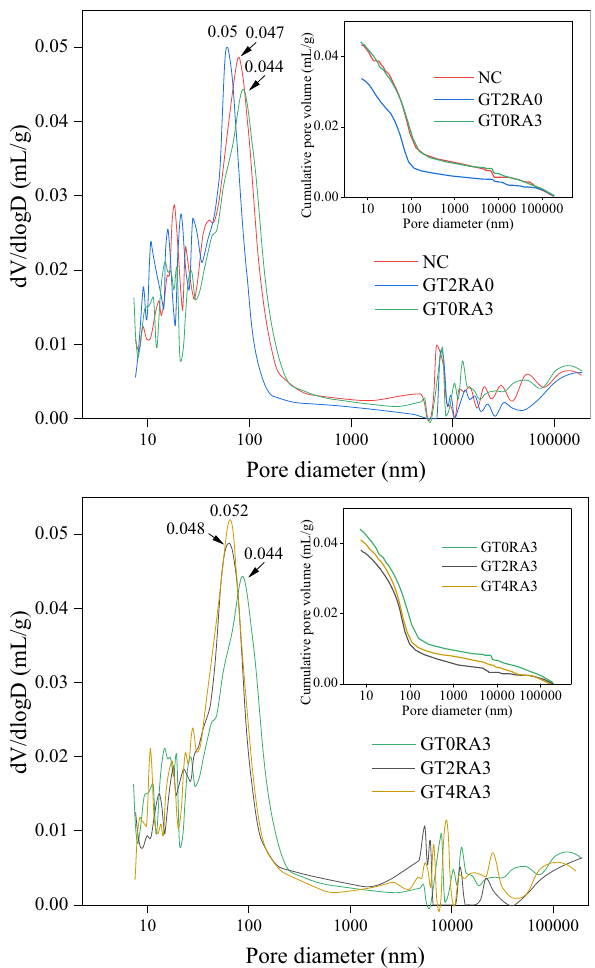
Figure 17: Pore size distribution of